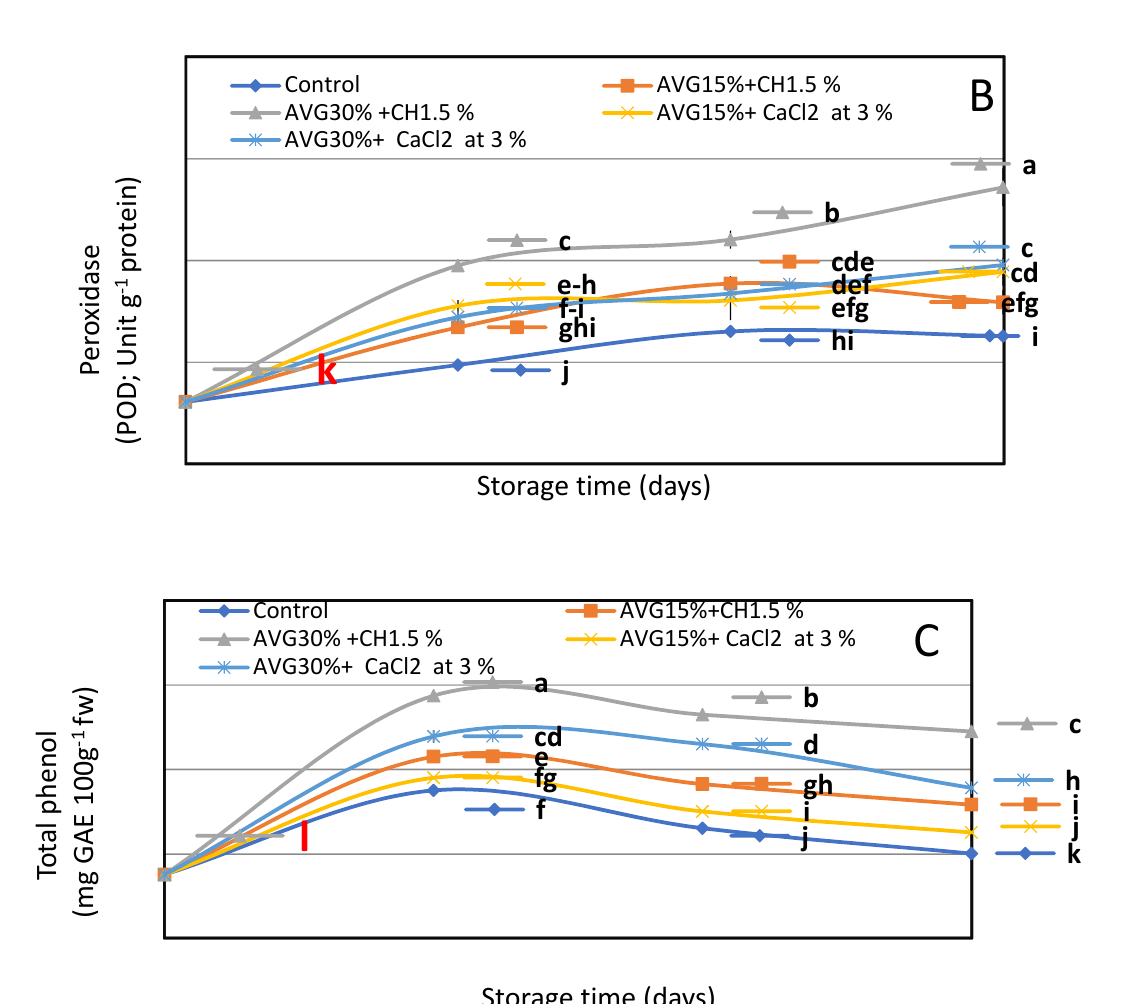
Figure 4. The effect of coating with AVG at 15 and 30% mixed with CH at 1.5% or CaCl 2 at 3% on CAT (Unit g − 1 protein) ( A ), POD (Unit g-1 protein) ( B ), and TPC (mg GAE 100 g-1 fw) ( C ) of ‘sultany’ peaches during cold storing at 3 ± 1 °C and 95 ± 1% RH for 36 days. The SE (±SE of n = 3) is shown by the vertical bars and the alphabetical letters indicated the significance at p ≤ 0.05 among treatments in each storing period. The average of both trial seasons (2020 and 2021) was analyzed by using Duncan’s Multiple Range Test. p -value of CAT, F1 = 0.530 F2 = 0.593 F1 × F2 = 1.214, POD, F1 = 1.064 F2= 1.189 F1 × F2 = 2.43 and TPC, F1 = 0.88 F2 = 0.99 F1 × F2 =